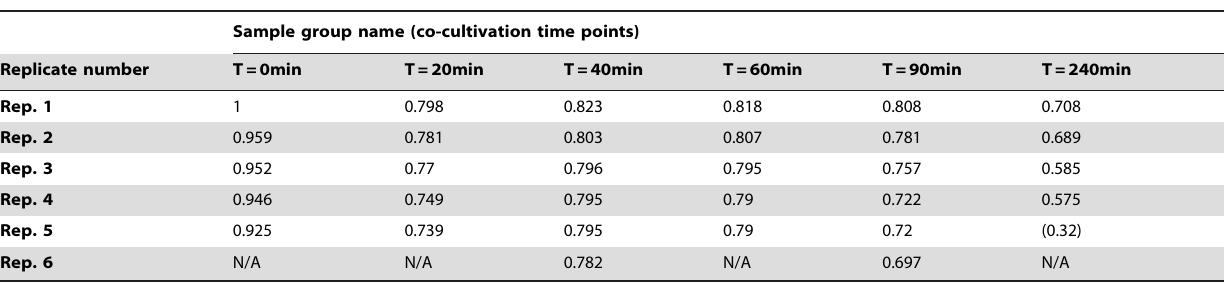
Table 2. Correlation of transcriptional patterns obtained from biological replicates (T= 0min Rep 1 or Rep1 T=0 is the base